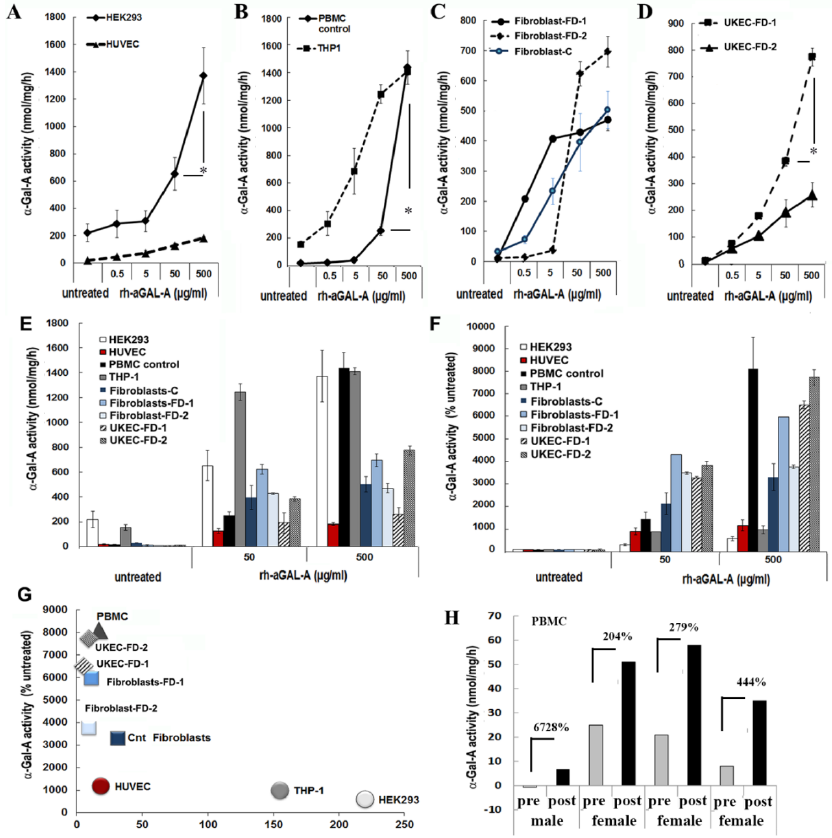
Figure 1. The efficiency of the delivery of recombinant α-Gal A enzyme (rh-α-Gal A). ( A ) HEK293 and Figure 1. The e ffi ciency of the delivery of recombinant α -Gal A enzyme (rh- α -Gal A). ( A ) HEK293 and HUVEC, ( B ) THP1 and control PBMC, ( C ) fibroblasts, and (D ) UKEC cells were treated with increasing concentration of rh- α -Gal A for 1 h. A total α -Gal A enzyme activity level was determined using 4-MU. * p < 0.05 50 vs. 500 µ g / mL of α -Gal A treatment ( E , D ) Comparing the total absolute ( E ) and relative ( D ) enzyme activity levels. Measurements performed at the concentrations of 50 and 500 µ g / mL were compared with the enzyme activity in untreated samples. ( G ) Correlation analysis between endogenous enzyme concentration and enzyme uptake e ffi ciency. ( H ) α -Gal A activity was measured immediately following ERT treatment. Blood was collected before (pre) and after (post) ERT infusion and PBMCs were isolated from FD patients, one male, and three females. Values represent 4-MU pre- and post-infusion levels. Samples were measured in